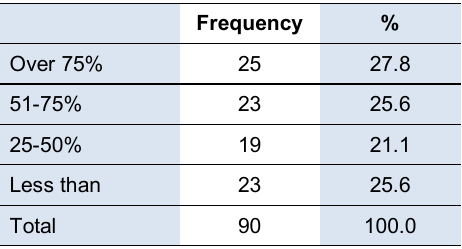
Table 7 - Psychotherapy activity contribution to earnings. n = 90